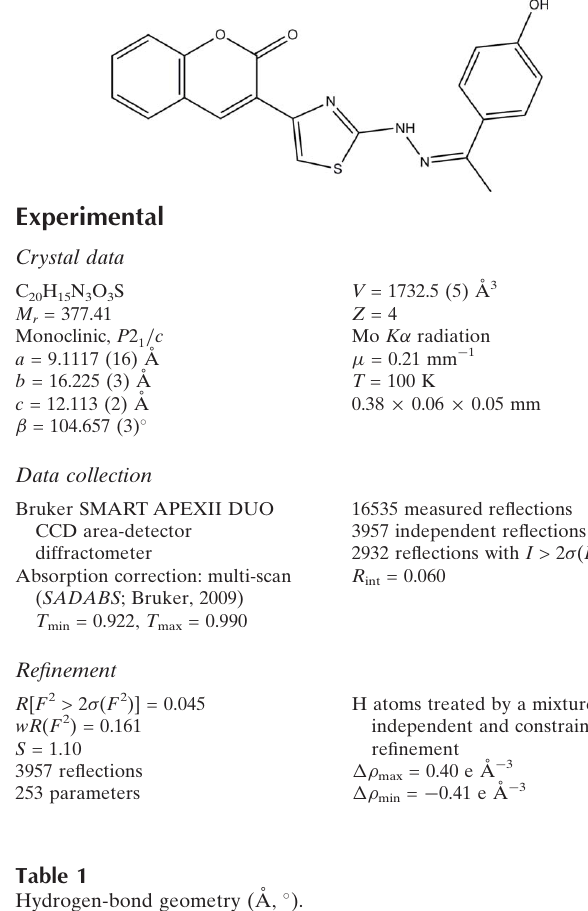
Hydrogen-bond geometry (A˚ , (cid:3)